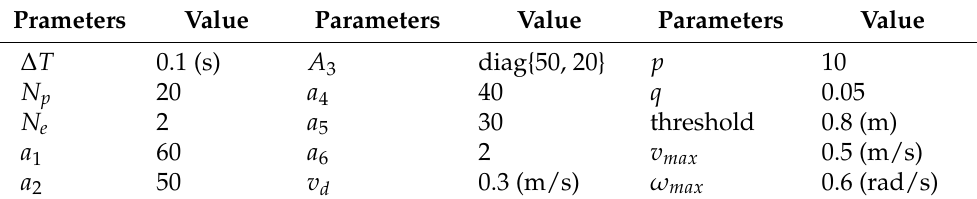
Table 2. Parameters in MPC